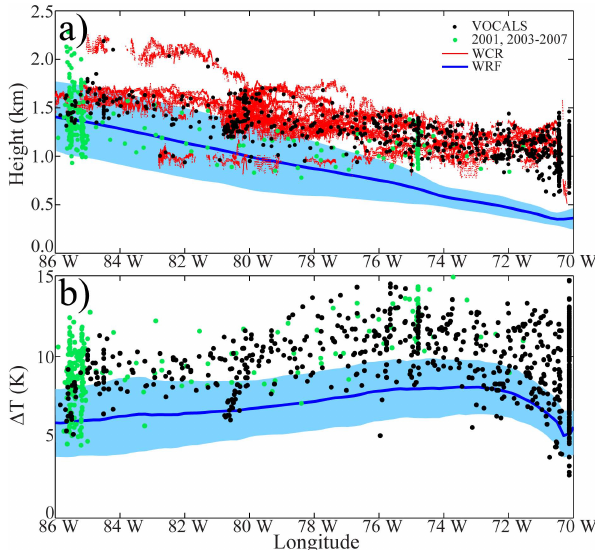
Fig. 4. Individual observations at 20 ◦ S of (a) the MBL height (km) and (b) inversion strength (K) from VOCALS-REx (black dots), previous cruises (green dots), and Wyoming Cloud Radar (red lines). In both panels, the blue shading represents WRF values within ± 1 standard deviation of the WRF 2-month average (solid blue